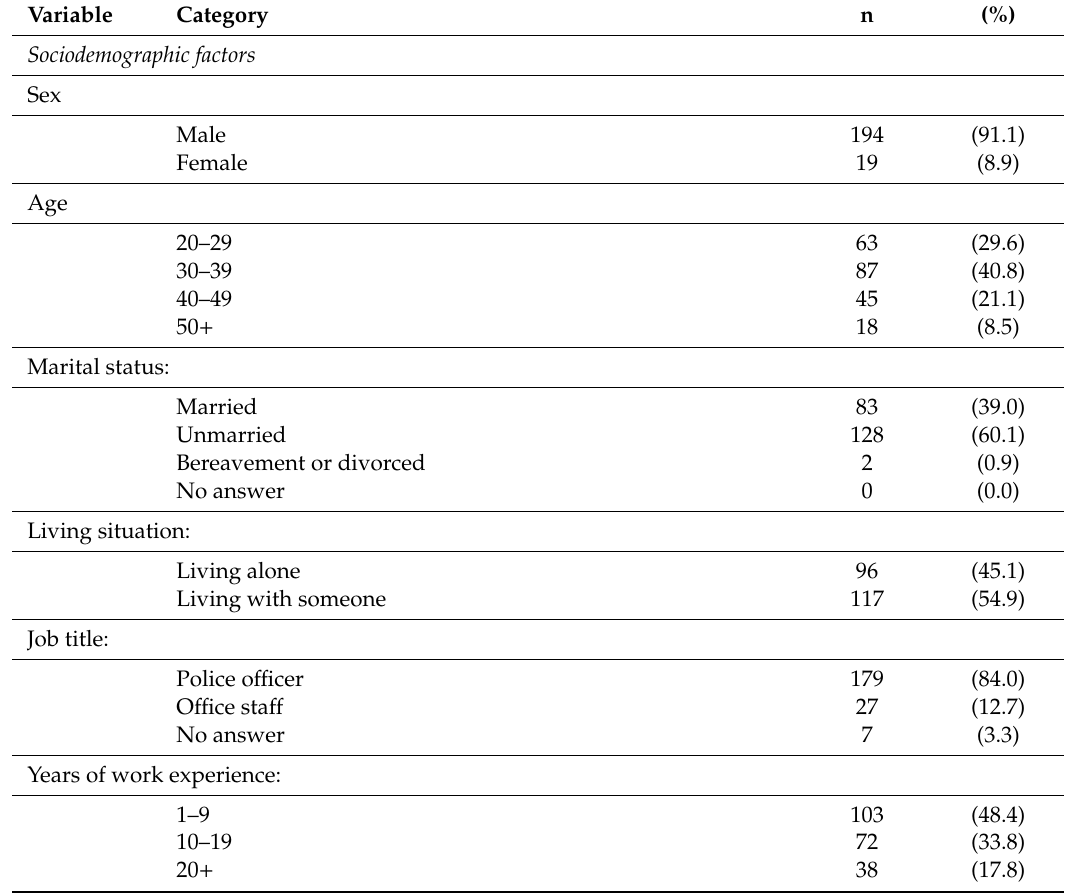
Table 1. Characteristics of the participants (n =